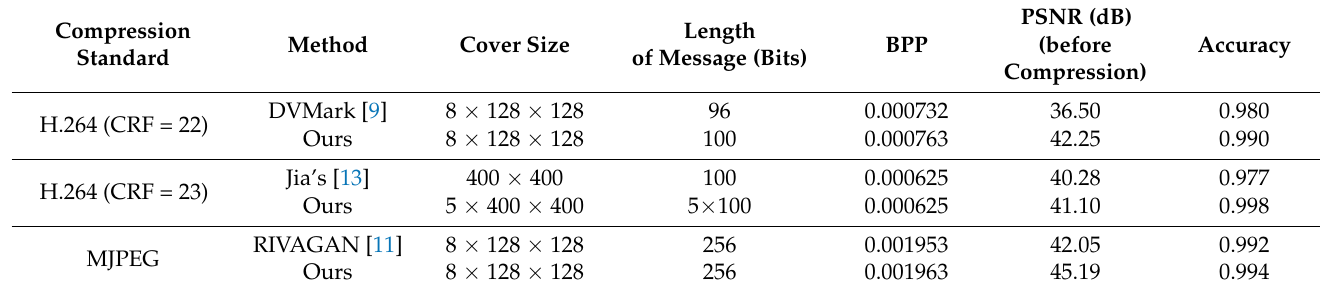
Table 3. Comparison results with DVMark [9], Jia’s method [13] and RIVAGAN